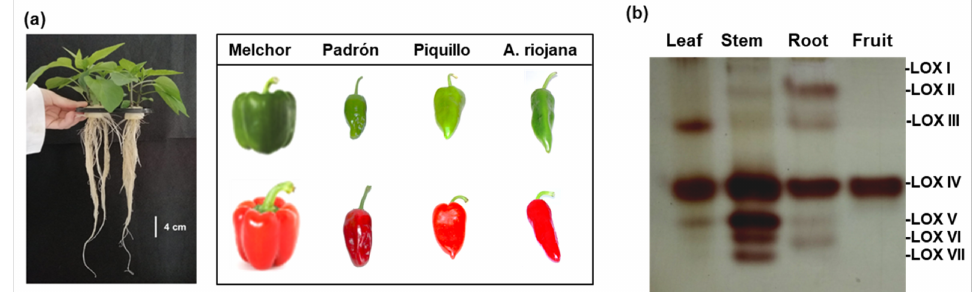
Figure 1. ( a ) Appearance of 30-day-old pepper ( Capsicum annuum L. cultivar Melchor) plants and fruits (green and red) from four pepper varieties including Melchor, Padr ó n, Piquillo, and Alegr í a riojana used in this study. ( b ) In-gel lipoxygenase (LOX) activity assay in the main organs of sweet pepper